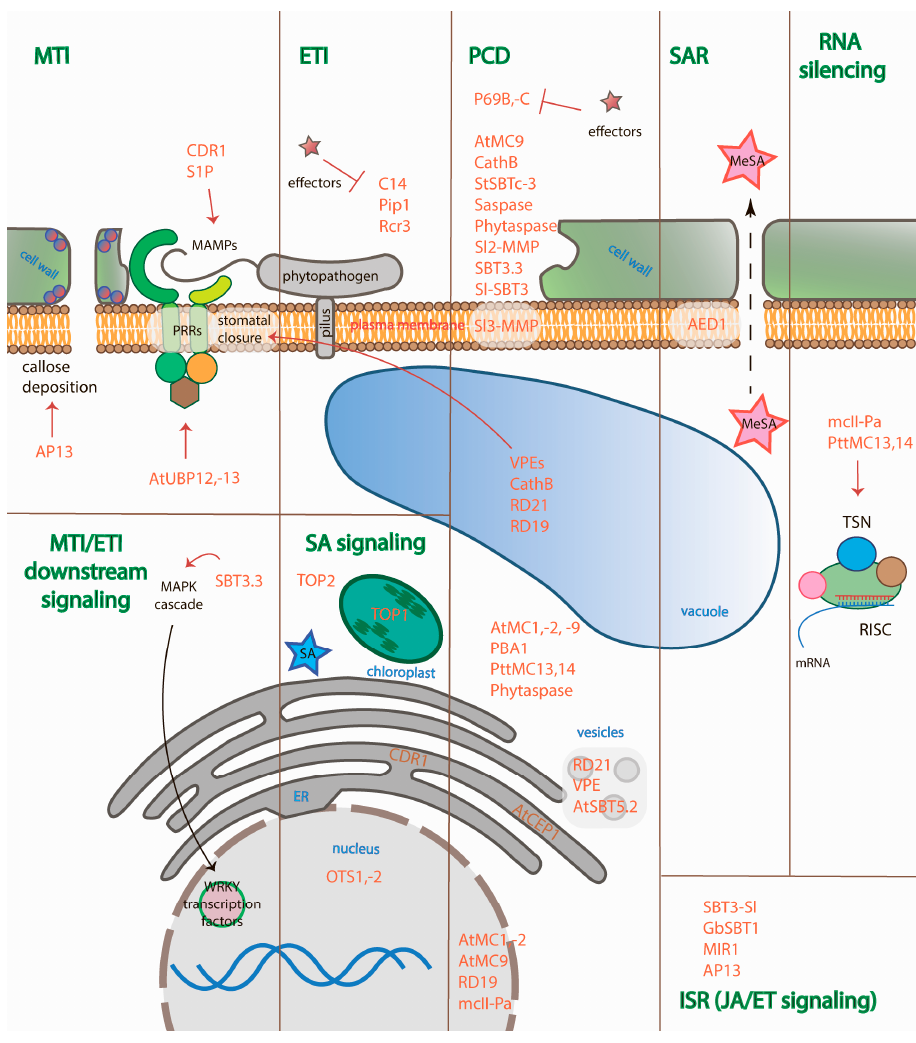
Figure 3. Involvement of plant proteases in different immunity pathways and their subcellular localization. Proteases covered in the review are colored orange. Immune processes are colored green. The names of cellular compartments are colored blue. Red arrows point to the object of the protease action (hydrolysis of the substrate or influence on the process); T-like arrows imply inhibition of proteases by effectors; black arrow indicates the direction of the MAPK cascade action; dotted arrow indicates the transport of signaling molecules through